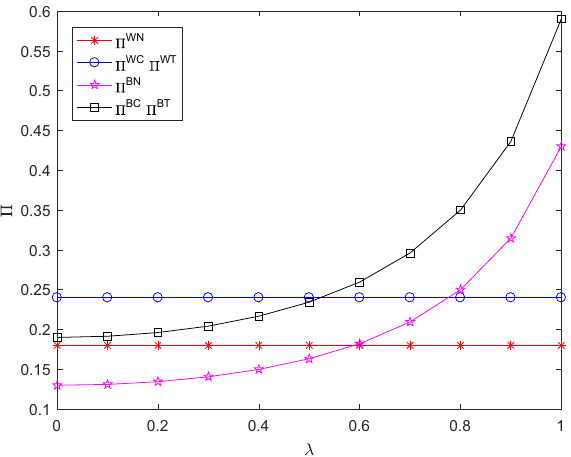
Figure 5. The supply chain total profit in different scenarios.